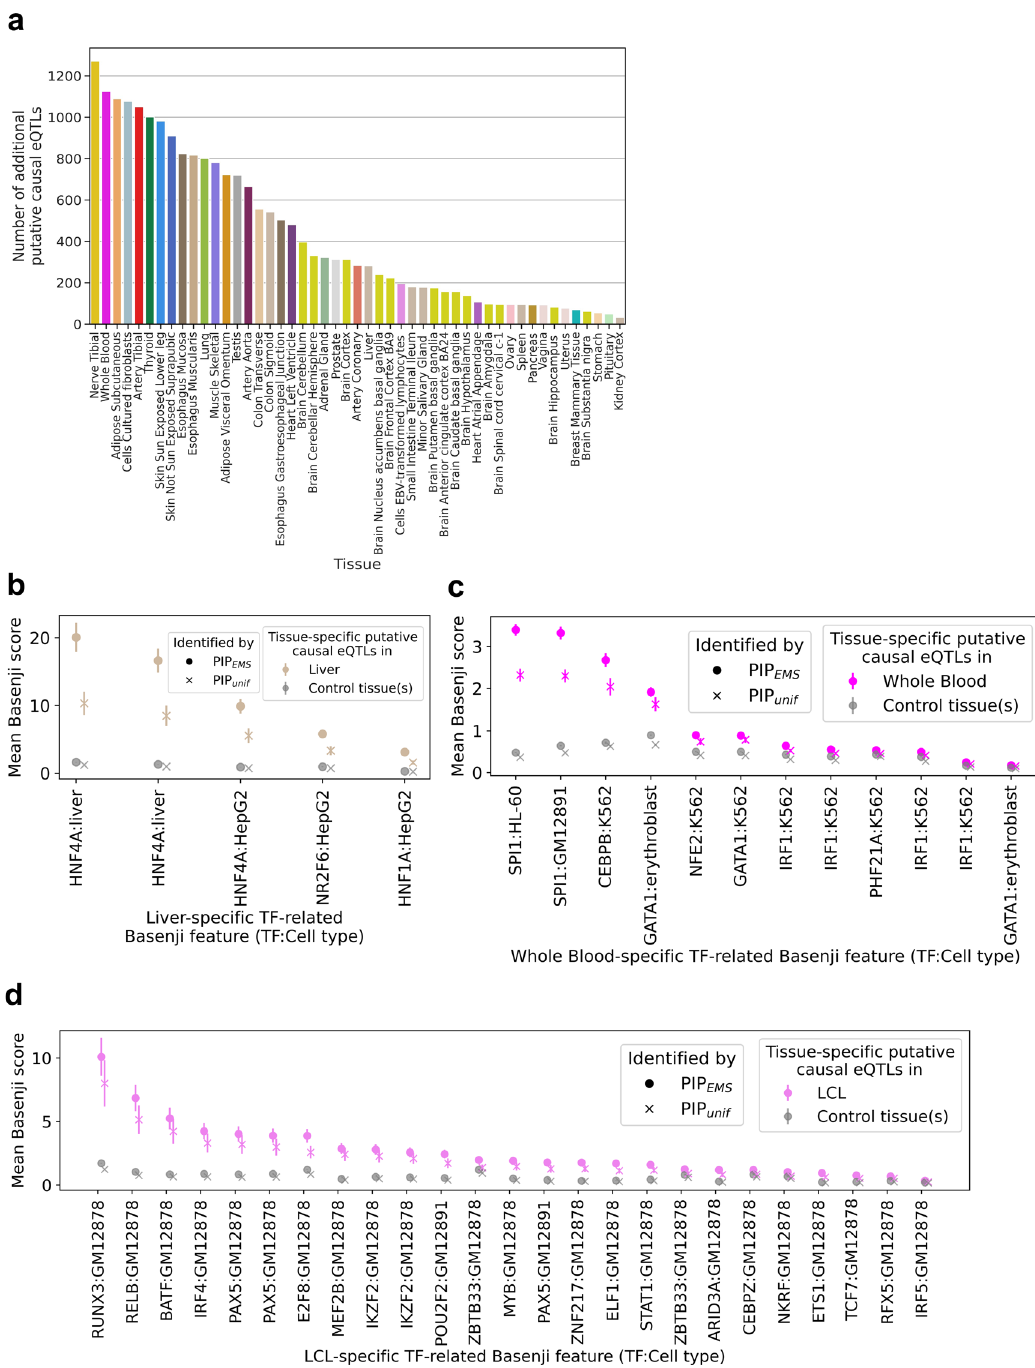
Fig. 5 Functionally informed fi ne-mapping across 49 tissues. a The number of additional putative causal eQTLs (de fi ned by PIP EMS > 0.9 and PIP unif < 0.9) for each tissue is shown in descending order. b – d Mean Basenji score in different classes of tissue-speci fi c putative causal eQTLs for tissue-speci fi c TF- related Basenji features for liver ( b ), whole blood ( c ), and LCLs ( d ). In 39 out of all 42 features across all three tissues, the mean Basenji score in tissue- speci fi c putative causal eQTLs identi fi ed by PIP EMS is signi fi cantly higher in the corresponding tissue than in control tissues ( t test p < 0.05/42). This changes to 36 in 42 when using PIP unif instead of PIP EMS . The enrichment of mean Basenji score in putative causal eQTLs in the corresponding tissue compared to control tissues is higher for PIP EMS than PIP unif for all 42 tissues ( p < 10 − 100 in aggregate), consistent with our understanding that functionally informed fi ne-mapping using EMS utilizes cell-type-speci fi c functional enrichments, identi fi ed from putative causal eQTLs identi fi ed with a uniform prior, to identify additional putative causal eQTLs. Duplicated names are distinct features corresponding to biological replicates in the TF activity measurements. Out of 17,960 tissue-speci fi c putative causal eQTLs, n = 222 were for liver ( b ), n = 1758 were for whole blood ( c ), and n = 140 were for LCL ( d